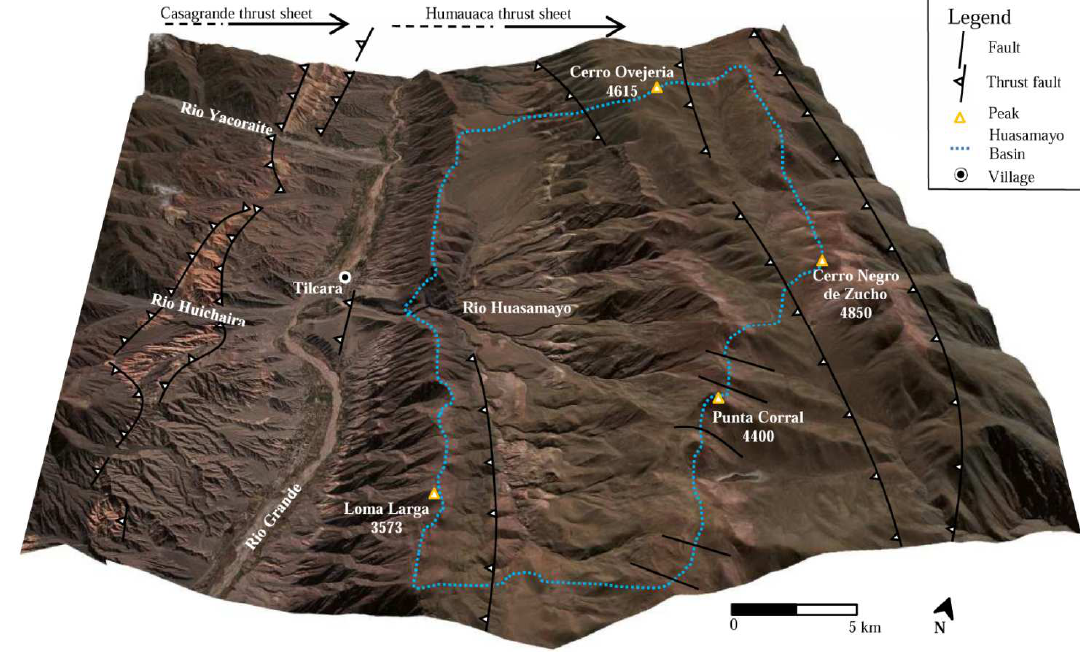
Fig. 2. Structural sketch map of the area (after Sancho et al., 2008). Image source: Google Earth.